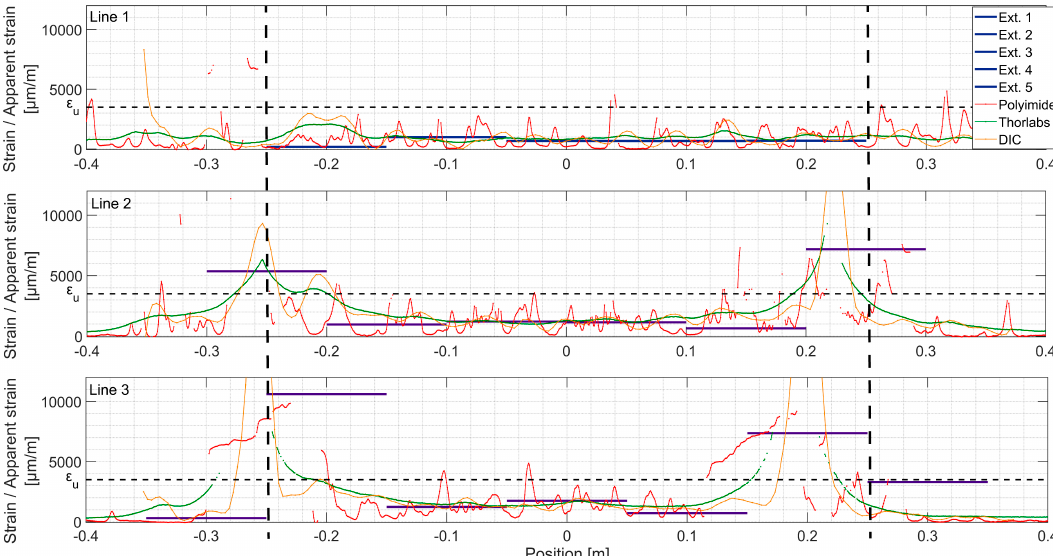
Figure 14. Strains measured with di ff erent techniques, load step 5, F = 205 kN; the constant bending Figure 14 . Strains measured with different techniques, load step 5, F = 205 kN; the constant bending moment zone is marked with dashed moment zone is marked with dashed lines.